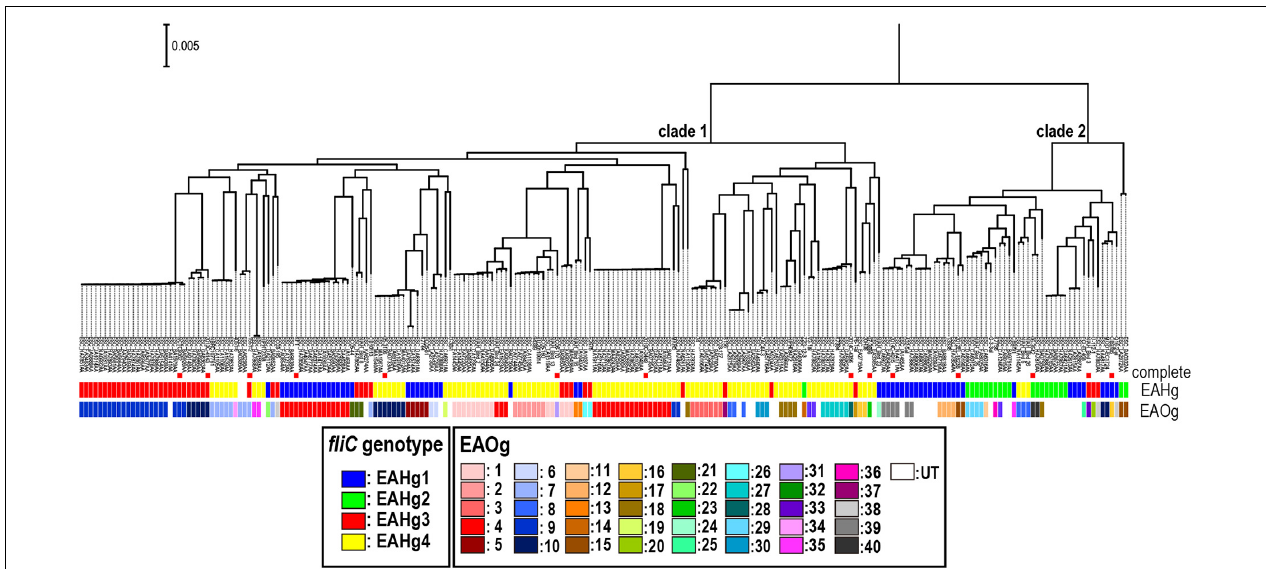
FIGURE 3 | Phylogenetic view of the 225 E. albertii strains that have been genome sequenced thus far (9) and the distribution of the four EAHgs and the 40 EAOgs in these strains. Strain names are indicated at each tip, and the 14 completely sequenced strains are indicated. Information on the distribution of the four EAHgs and the 40 EAOgs are also